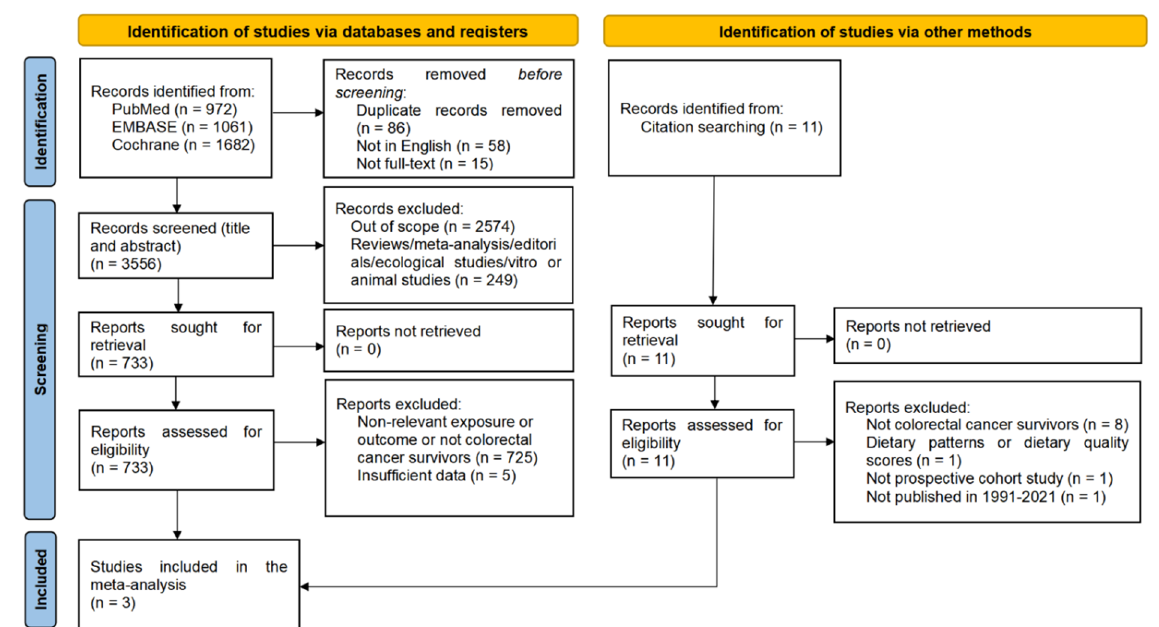
Figure 1. Flow chart of study selection.